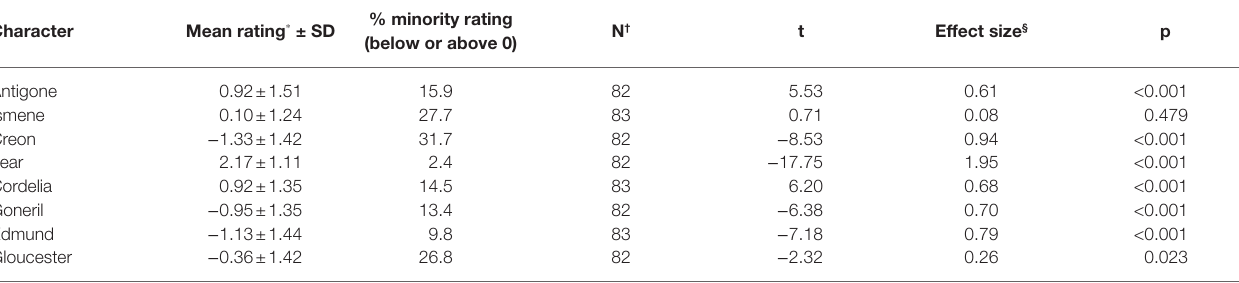
TABLE 5 | Distribution of moral approval ratings for characters (two performances pooled).